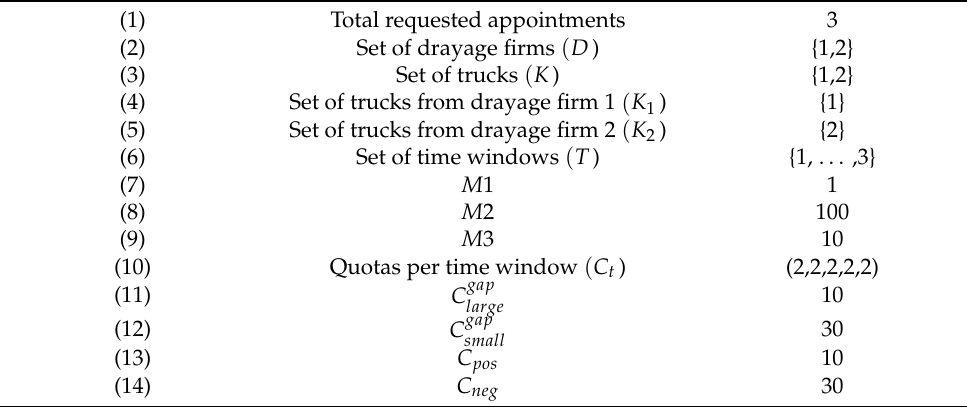
Table 4. Parameters of illustrative